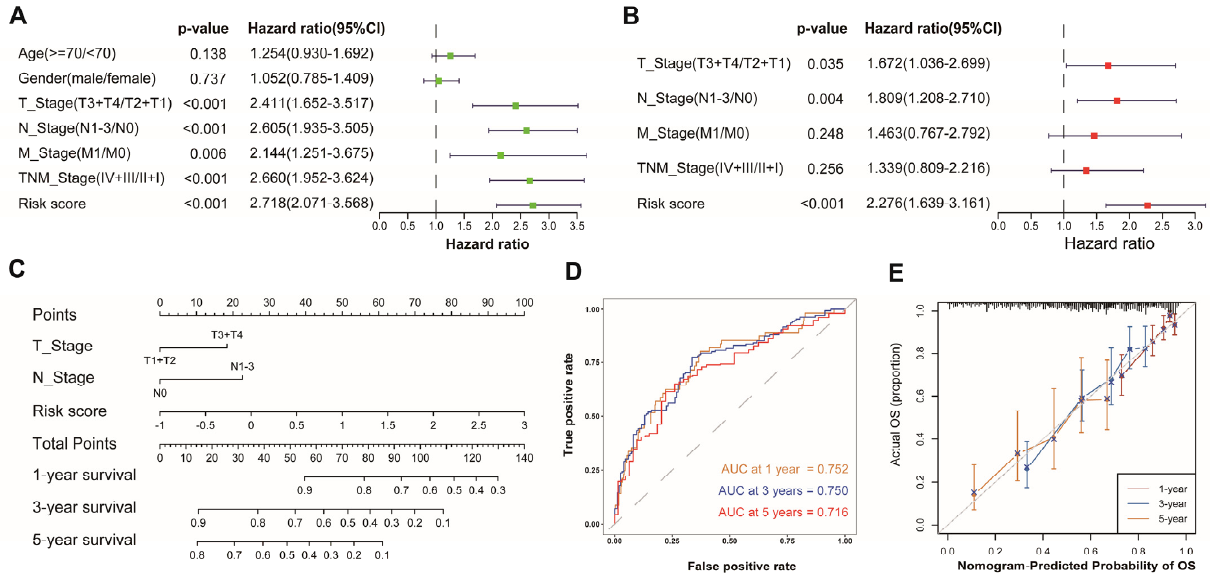
Figure 5. Establishment and assessment of a nomogram in the TCGA cohort. Univariate ( A ) and multivariate ( B ) analyses of risk score and clinicopathological features. ( C ) Nomogram for predicting 1-, 3-, and 5-year survival probability. ( D ) AUC values derived from time-dependent ROC of the nomogram. ( E ) Calibration curves for evaluating the compatibility between the predicted and actual OS.